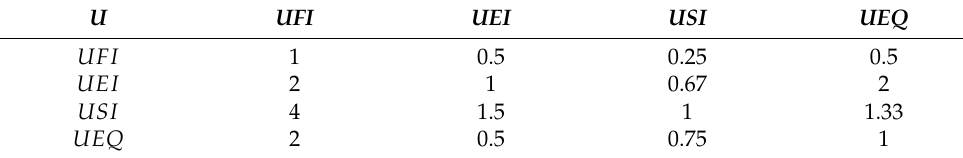
Table 11. Comparison matrix U